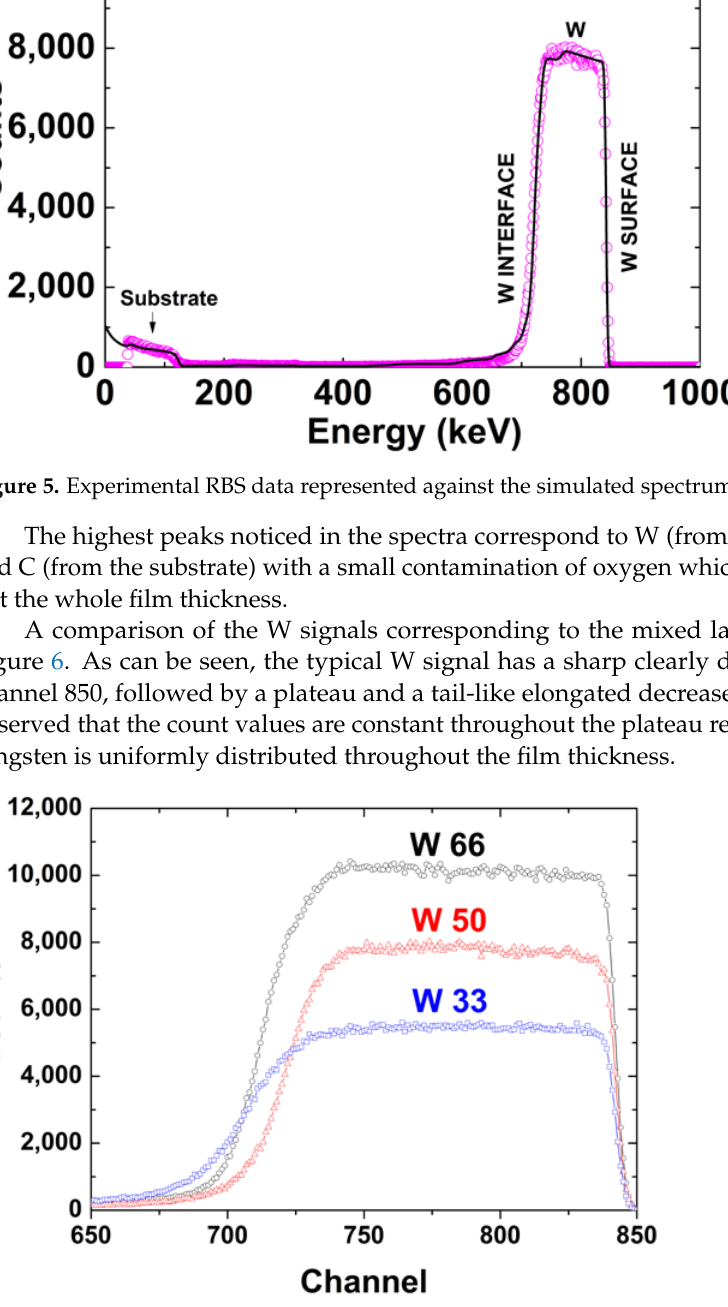
Figure 6. Comparative tungsten signal resulted from the RBS experimental spectra of the mixed Be- W